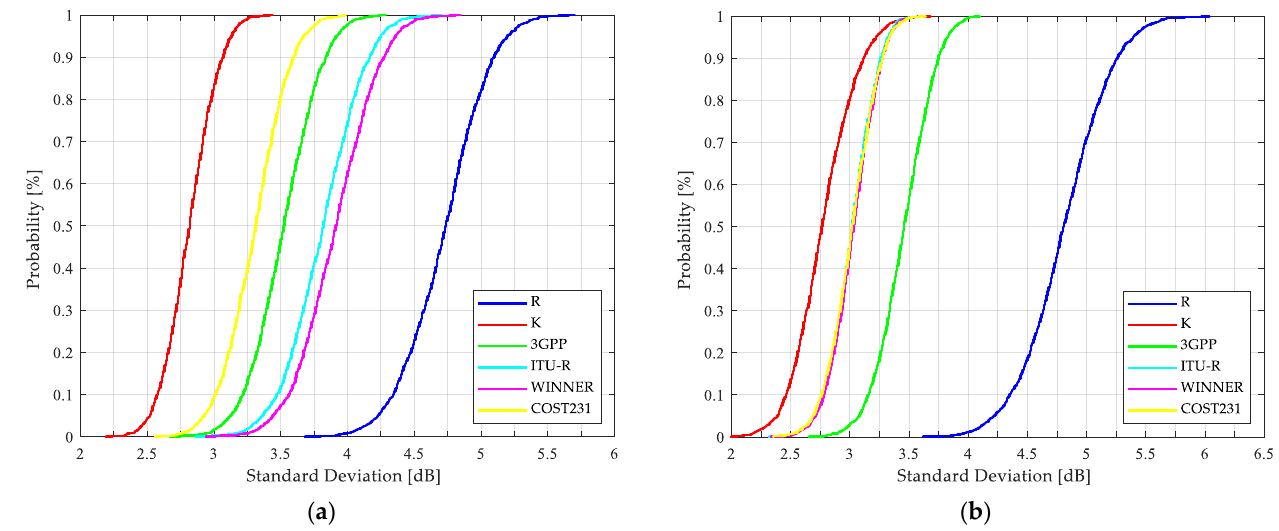
Figure 7. CDFs of mean error for path loss predictions based on different models: ( a ) SS O2I links; ( b ) OS O2I links.